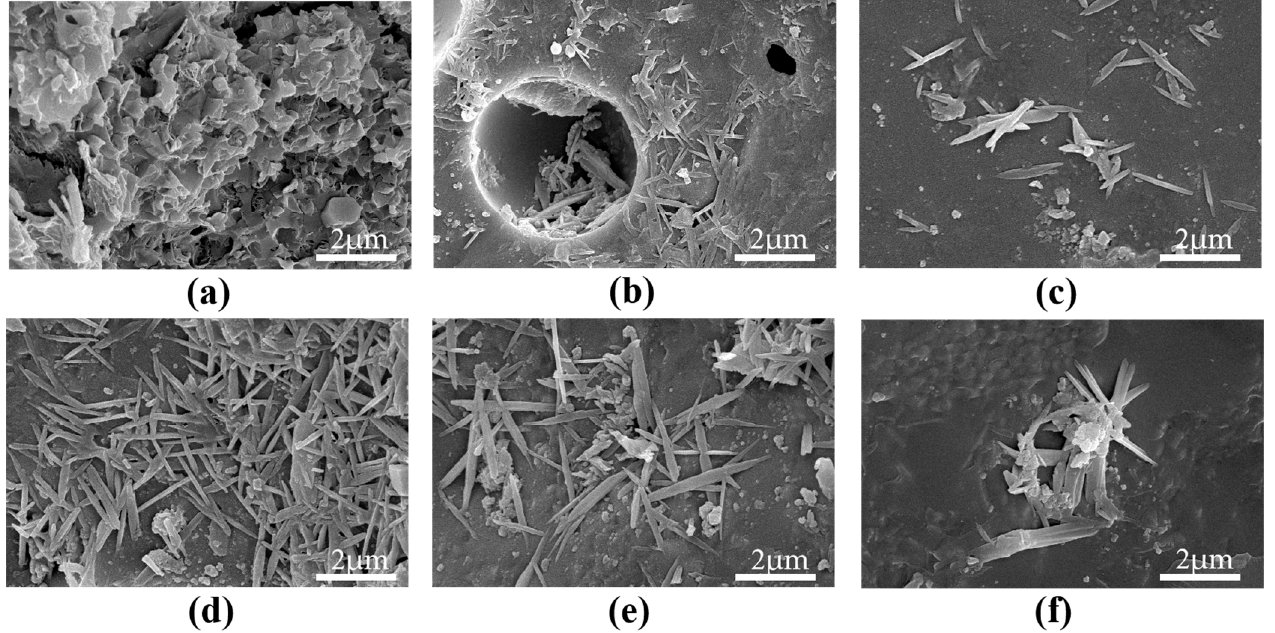
Figure 13. SEM images of different kinds of mix proportions at 28 days: ( a ) GO-0; ( b ) GO-2; ( c ) GO-4; ( d ) GO-5; ( e ) GO-6; ( f ) GO-8.